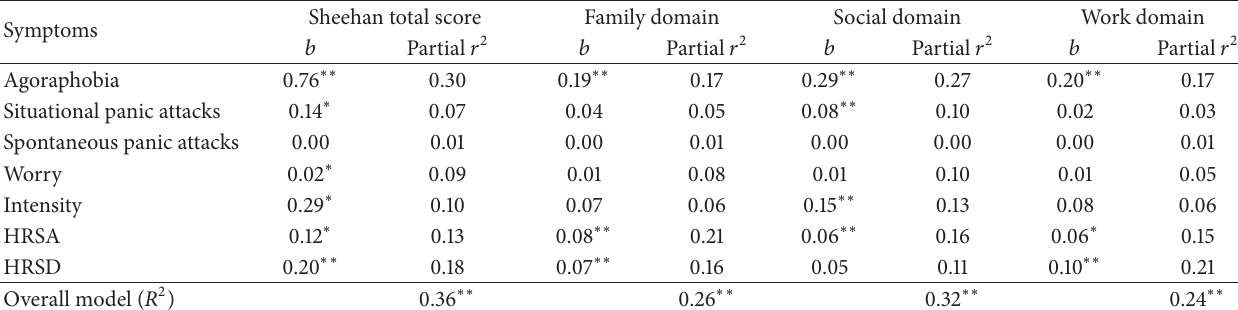
Table 4: Linear regression of disability and anxiety and depression